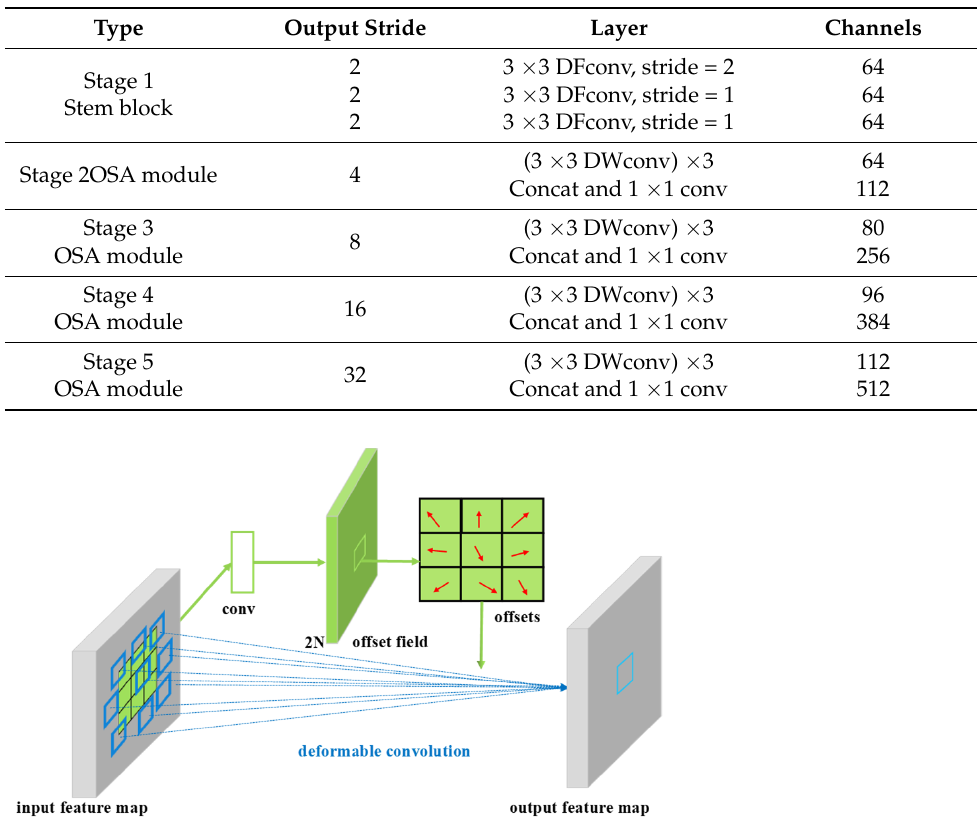
Table 1. Network Structure of LWB19.